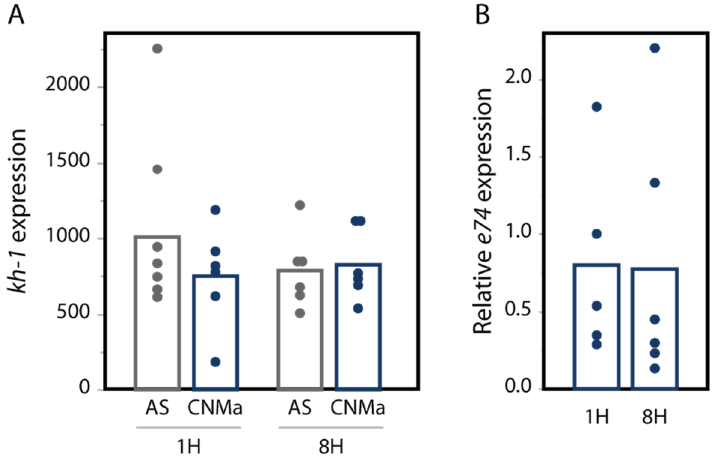
Figure 7. CNMa does not influence expression of ( A ) the JH-responsive gene kh-1 or ( B ) the 20- hydroxyecdysone gene e74 . qPCR was performed for kh-1 as described in the methods. For e74 , expression is relative to e74 expression in AS-treated insects. Treatment of insects with CNMa did not significantly impact expression regardless of time administered or gene tested (MANOVA e74 : F 3,19 = 0.8192, p = 0.50; kh-1 : F1,20 = 0.5141, p = 0.68).